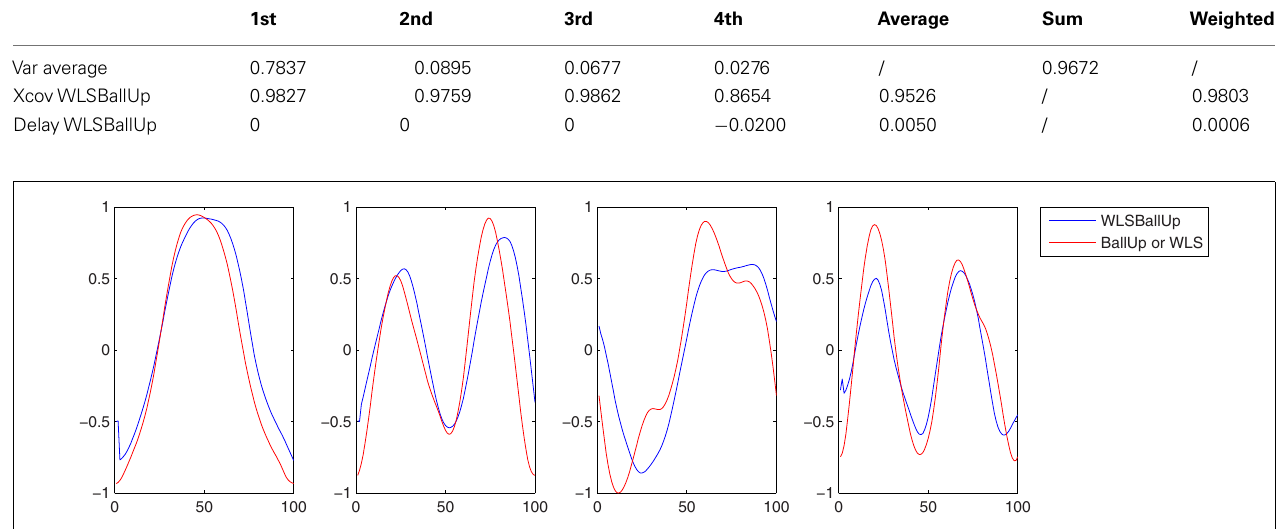
FIGURE 6 | Comparison between the average kMPs of reaching a target with the hand while walking (blue line) and the average kMPs of reaching (red line, first and second graph), and walking (red line, third and fourth graph) .